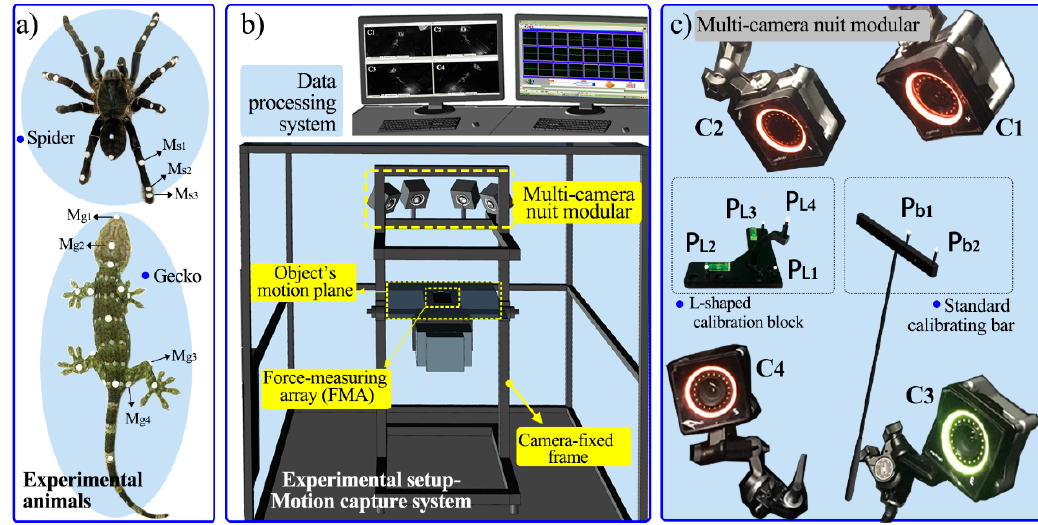
Figure 5. Experimental animals and setup ( a ) Experimental animals with markers on the body and legs (above: a spider; lower: gecko;) and the markers defined need data processing. for data processing; ( b ) Experimental equipment (including multi-camera unit modules), object motion plane, 3D motion reaction test platform, camera fixed frame and data transmission and processor); ( c ) Partial enlargement of the multi-camera unit module (including 4 cameras: C1, C2, C3 and C4) and a standard calibration bar (A black link device with two markers P b1 , P b2 fixed) and an L-shaped calibration block (Installed with 4 vertical markers P L1 , P L2 , P L3 , P L4 ) used as the calibration tools in the middle of the picture.